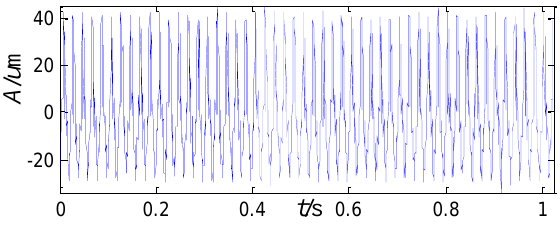
Figure 13. The waveform of the sensor-dependent vibration signal in time domain after maintenance.